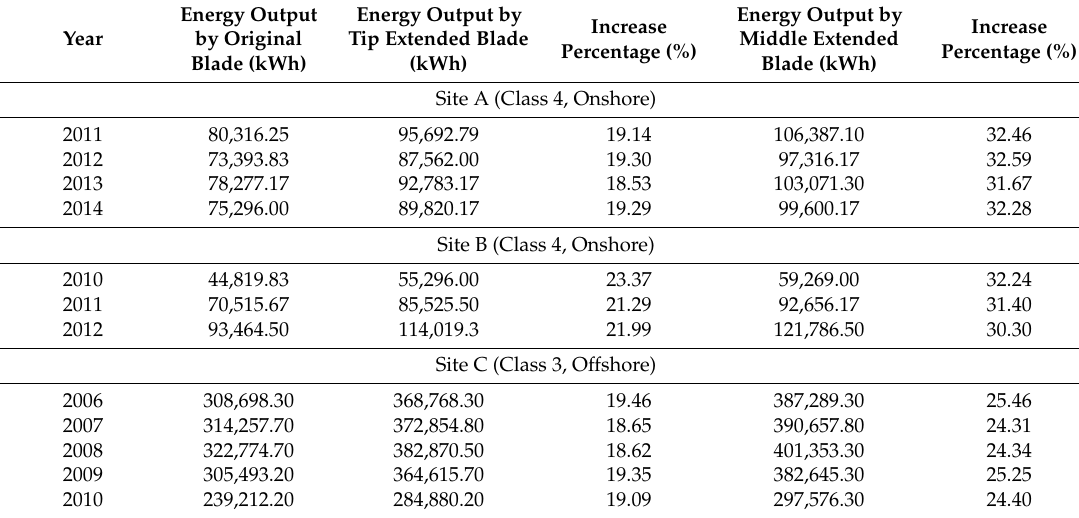
Table 6. Comparison of total annual energy production by the original blade versus extensible blades at different